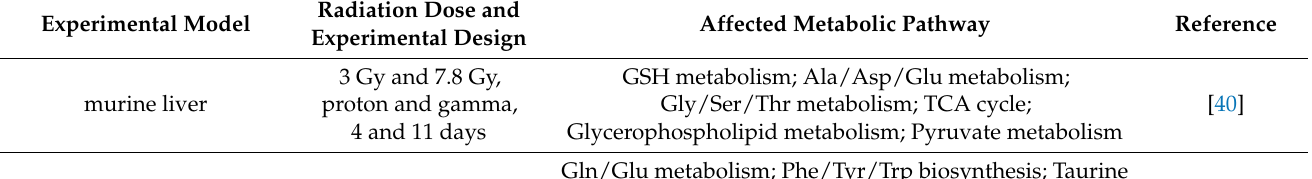
Table 2. Radiation-induced modulation of metabolic pathways. Pathways were identified using the MetaboAnalyst 5.0 software based on radiation-affected